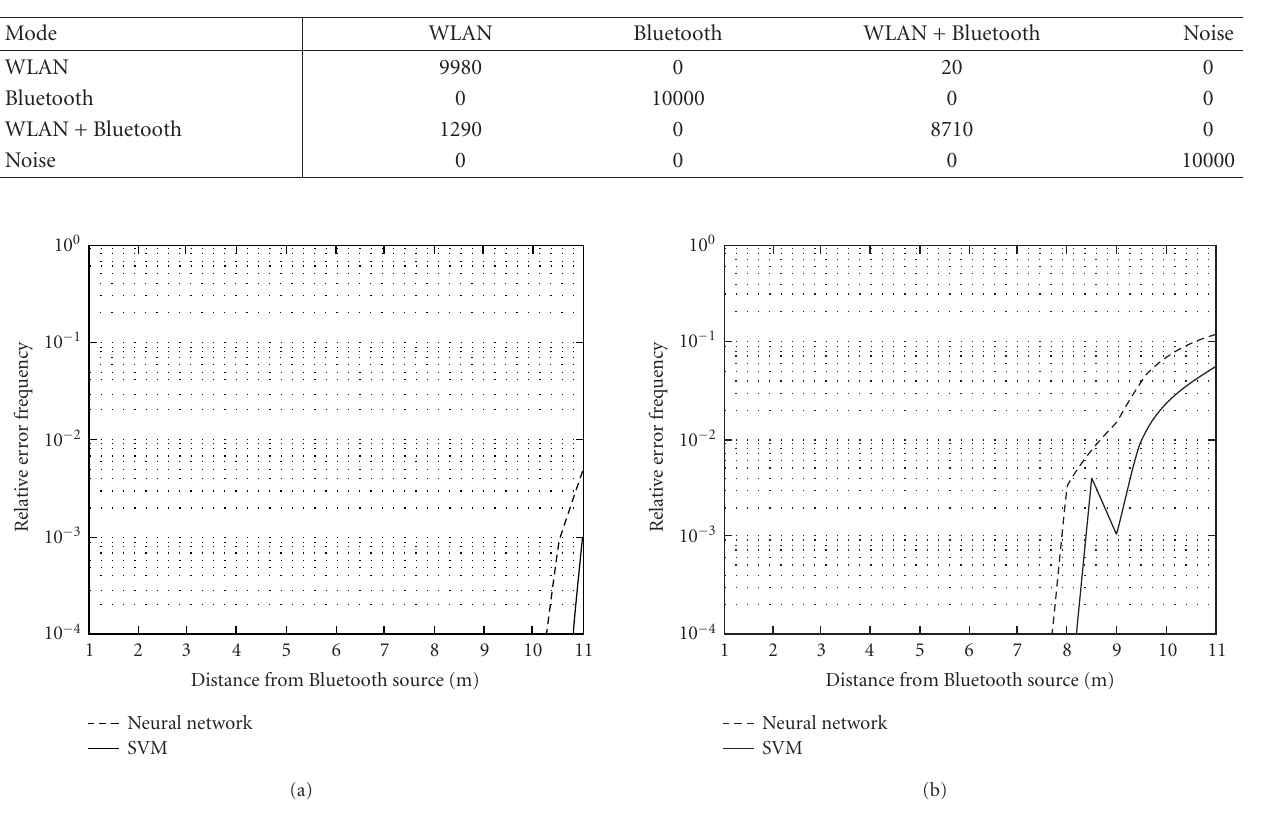
Figure 10: Relative error frequency of Bluetooth by using (a) Choi-Williams and (b)